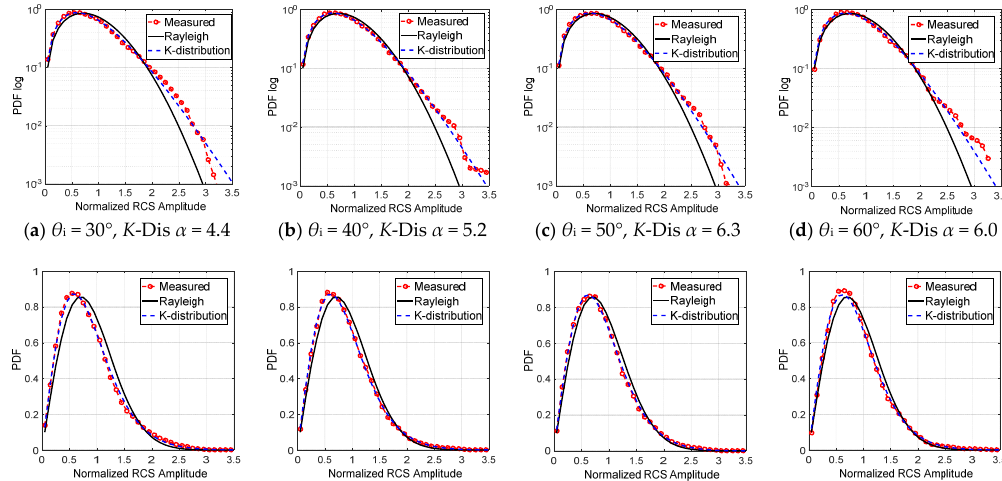
Figure 9. The normalized amplitude PDF curves of measured images at different θ i , at the resolution cell size of 30 mm, VV, compared with Rayleigh distribution and K ‐ distribution. (Sample parameters are shown in Table 1).